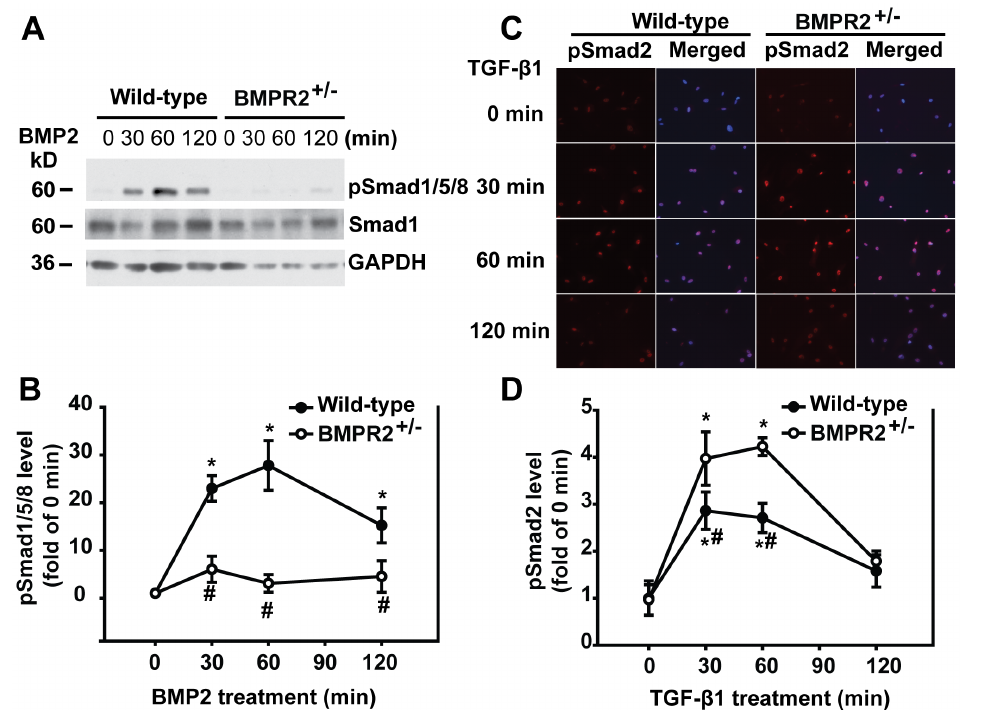
Figure 6. BMPR2 deficiency increased Smad2 phosphorylation in PSCs. (A) Wild-type and BMPR2 + / 2 PSCs were treated with 250 ng/ml of BMP2 for the indicated time points. The whole cell lysates were subjected to Western blotting with anti-pSmad1/5/8 and total Smad1 antibodies. (B) Quantification of the Western blots. The protein levels were normalized against GAPDH and quantified as fold of 0 min. * P , 0.05 compared with 0 min, # P , 0.05 compared with the same time points of wild-type. Wild-type: n=3, BMPR2 + / 2 : n=3. (C) Wild-type and BMPR2 + / 2 PSCs were treated with 1 ng/ml of TGF- b 1 for the indicated time points. Immunofluorescence was performed using antibody against pSmad2 (red). The cell nucleus was stained with DAPI (blue). The images of pSmad2 and pSmad2 merged with DAPI were presented. (D) Quantification of fluorescence intensity from 3 different fields per sample. * P , 0.05 compared with 0 min, # P , 0.05 compared with the same time points of wild-type PSCs. Original magnification 6